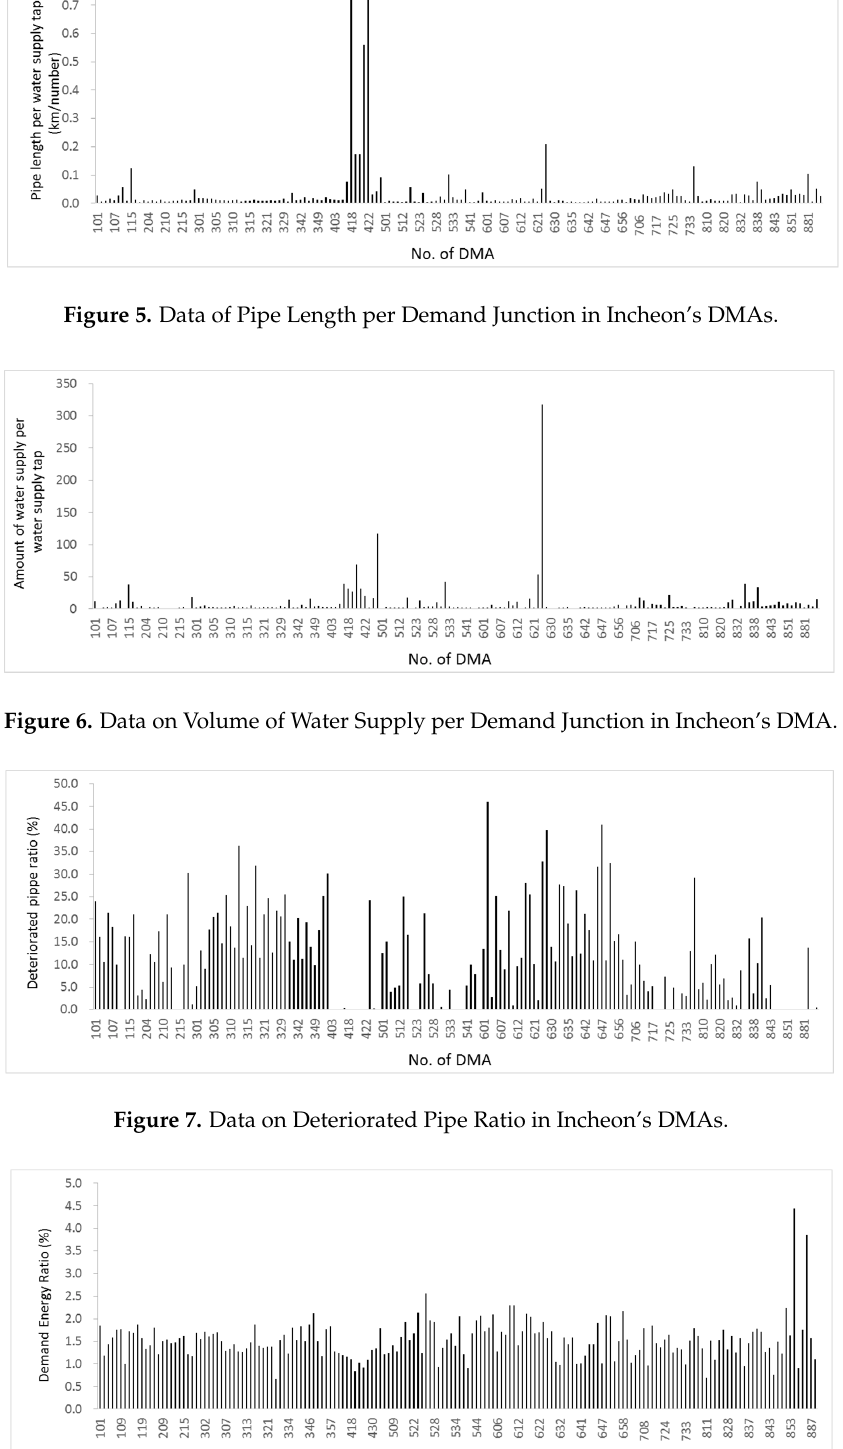
Figure 8. Data on Demand Energy Ratio in Incheon’s DMAs.